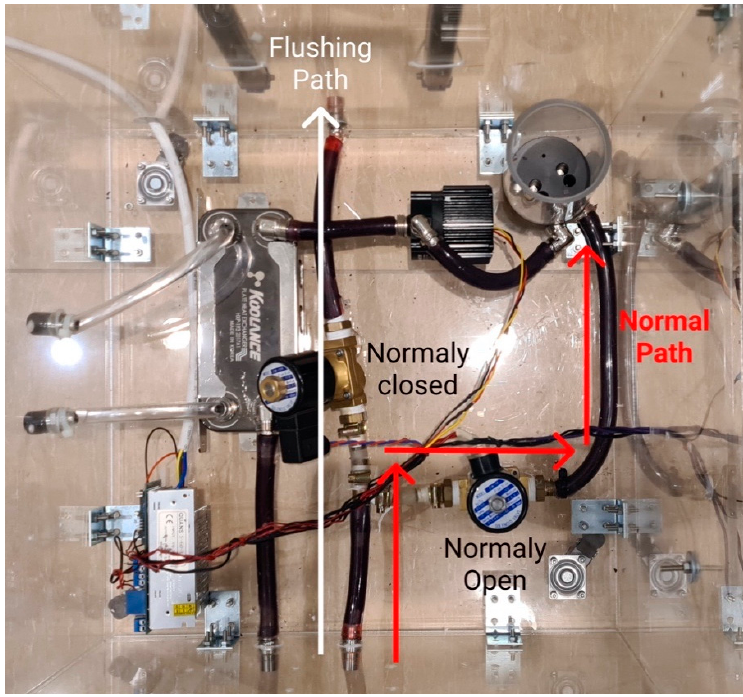
Figure 13. Implemented automatic fluid flushing module.